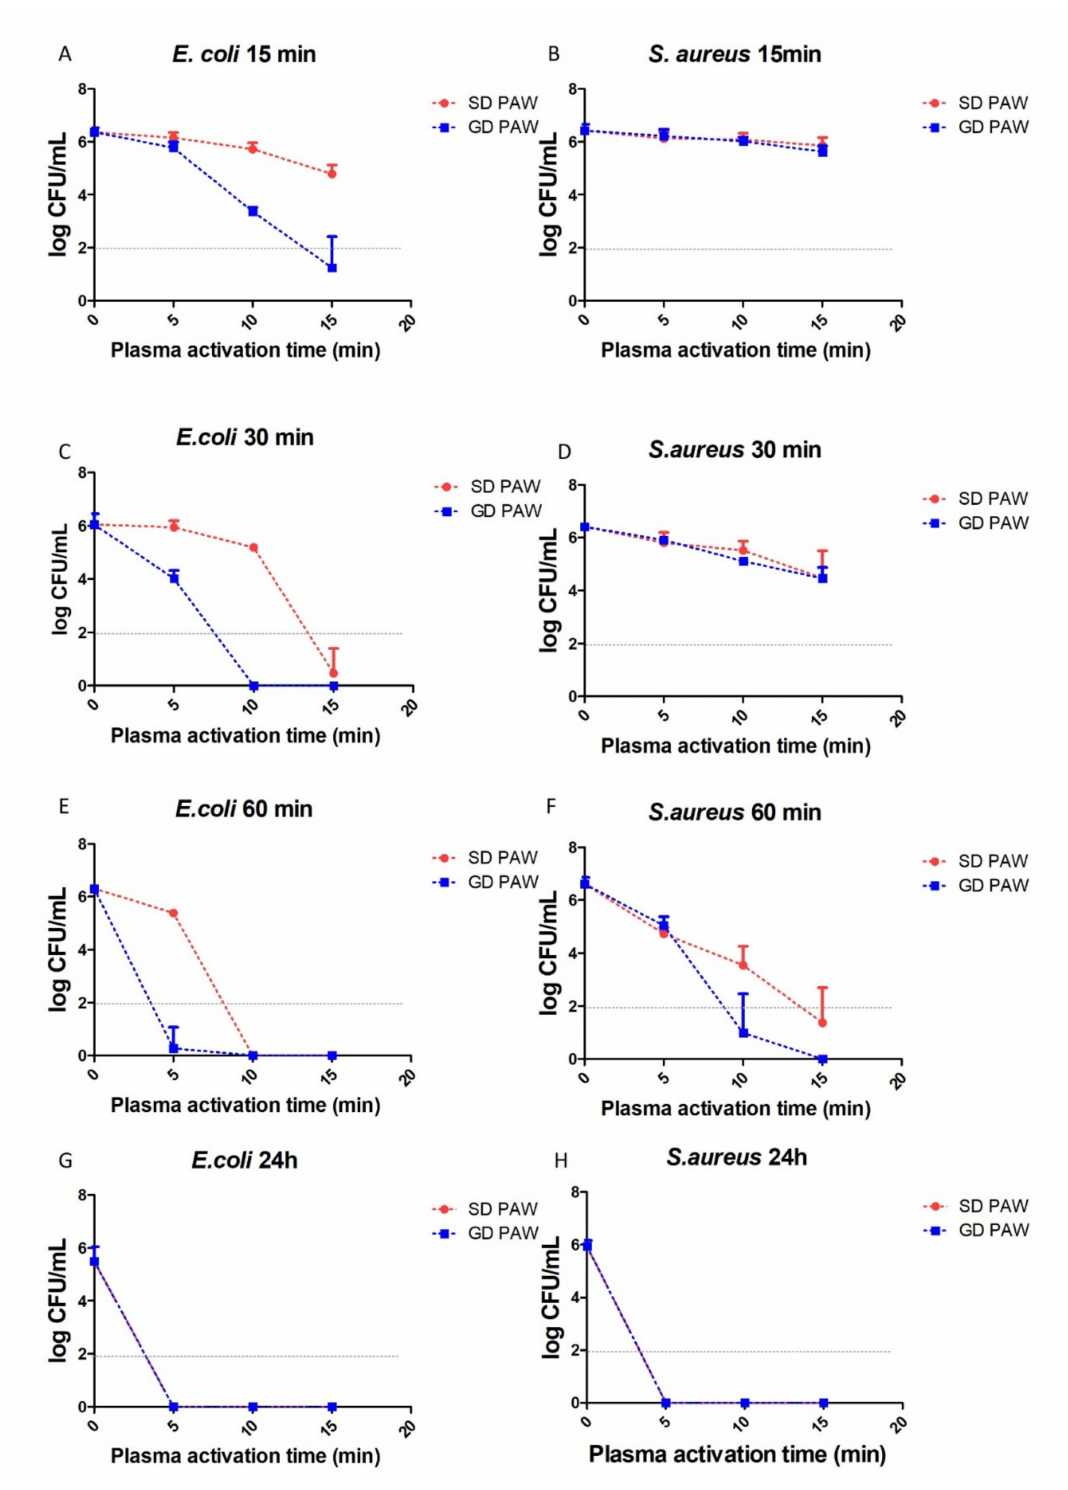
Figure 3. Bactericidal effects of PAW after 5, 10, or 15 min plasma activation, made by spark and glow discharges, on Escherichia coli ( E. coli ) and Staphylococcus aureus ( S. aureus ) with contact times of 15, 30, 60 min and 24 h on the day of PAW generation. ( A ) E. coli —15 min; ( B ) S. aureus —15 min; ( C ) E. coli —30 min; ( D ) S. aureus —30 min; ( E ) E. coli —60 min; ( F ) S. aureus —60 min; ( G ) E. coli —24 h; ( H ) S. aureus 24 h (data shown as mean ± SD, average of three experiments). Limit of detection: 2 log 10